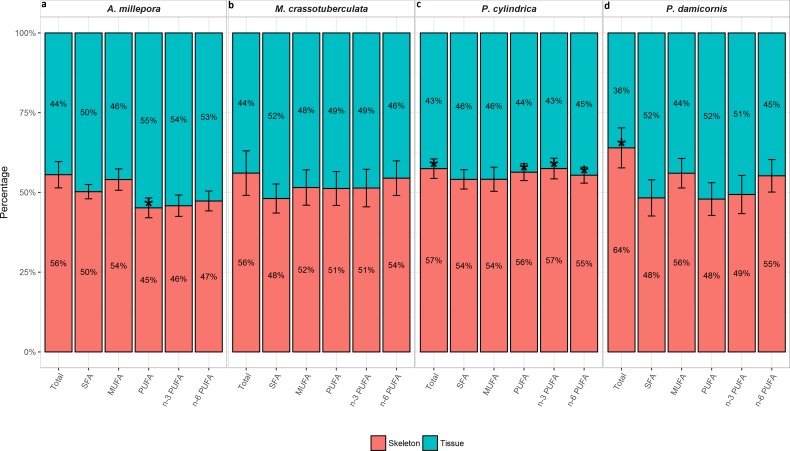
Fatty acid composition of denuded skeleton and isolated tissue of four scleractinian species prepared with the air-spraying method—relative contribution (% total) Values are presented as means ± SEM (n = 20).* denote significant differences between stacked bars within each species (tissue vs skeleton) (P < 0.05).